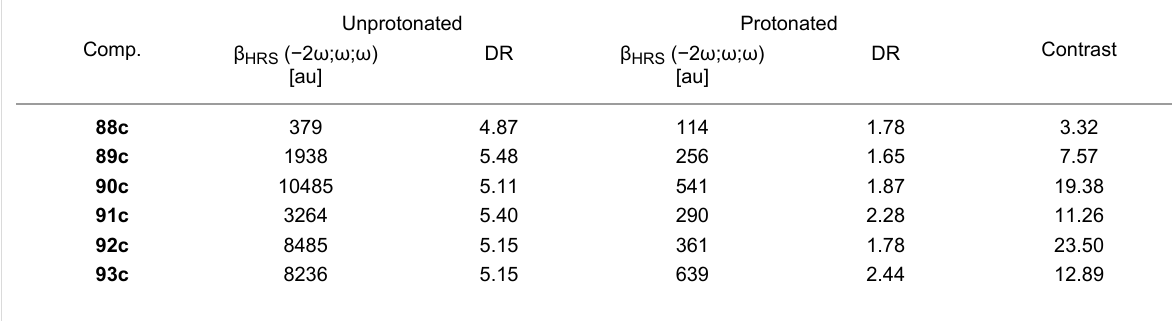
Table 11: HRS first hyperpolarizabilities ( β ) and depolarization ratios (DR) of 88c – 93c before/after protonation (CH 2 Cl 2 ) [109].